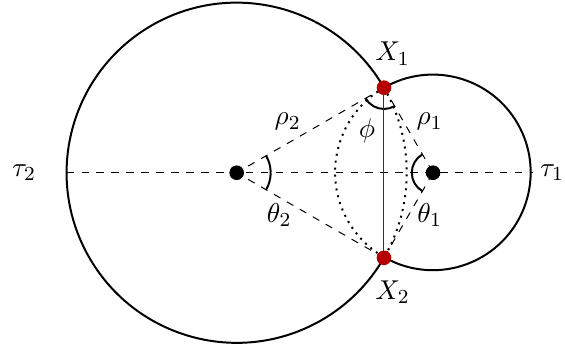
Figure 3 . The curve that maximizes the action with two operator insertion (red dots) at (cid:28) 1 = (cid:28) and (cid:28) 2 = (cid:12) (cid:0) (cid:28) . The horizons of each side are located at the black